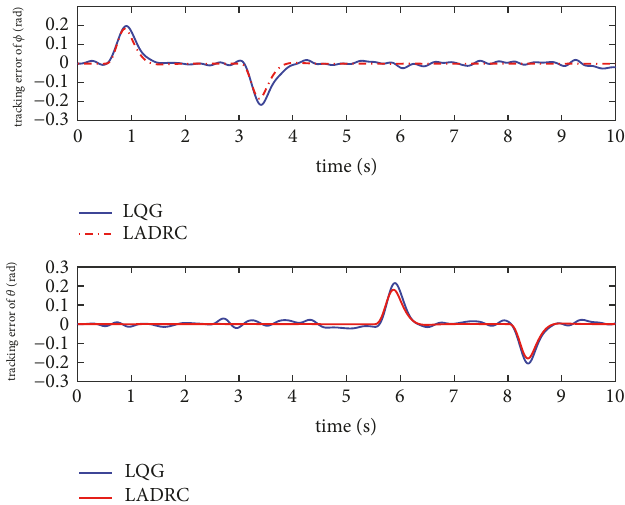
Figure 10: Tracking error of both